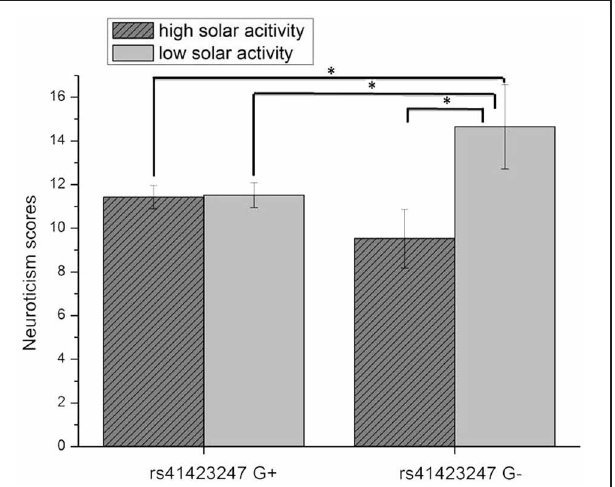
FIGURE 3 | Interaction effect of rs41423247 (G ± ) by solar activity in the first trimester (high/low) on neuroticism (means and SEM are presented; ∗ p < 0 . 05).